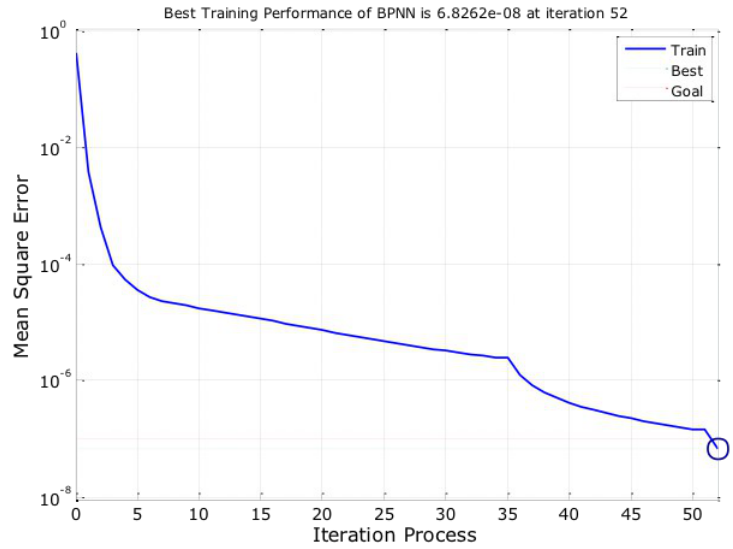
Figure 6. Training performance of BPNN model with given parameters